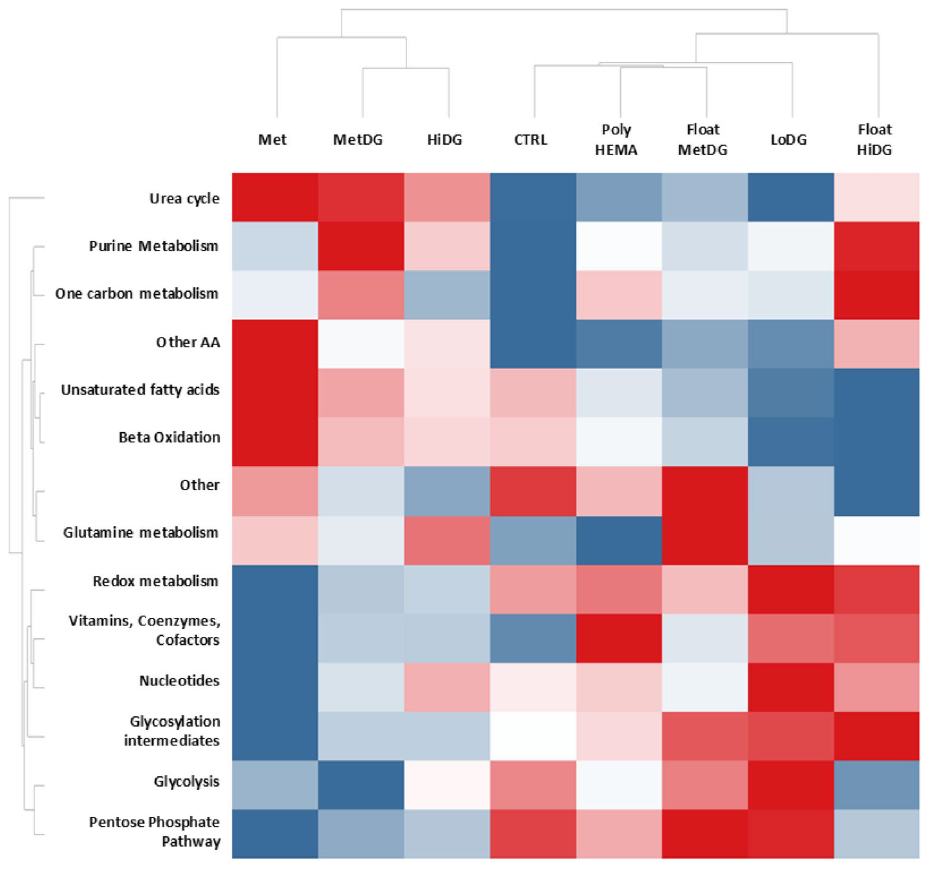
Figure 2. Heat map of selected metabolite levels according to major metabolic pathways. Measured metabolites were classified according to their primary metabolic pathways (refer to Supplementary Table 2). For each pathway and treatment group, the log-median-QC normalized value was used. Red—maximum levels, blue— minimum levels. Met—attached 5 mM metformin treated cells, MetDG—attached 5 mM metformin + 0.6 mM 2DG treated cells, HiDG—attached 4.8 mM 2DG treated cells , CTRL—attached untreated control cells, poly-HEMA—floating untreated cells grown on poly-HEMA, FloatMetDG—floating detached 5